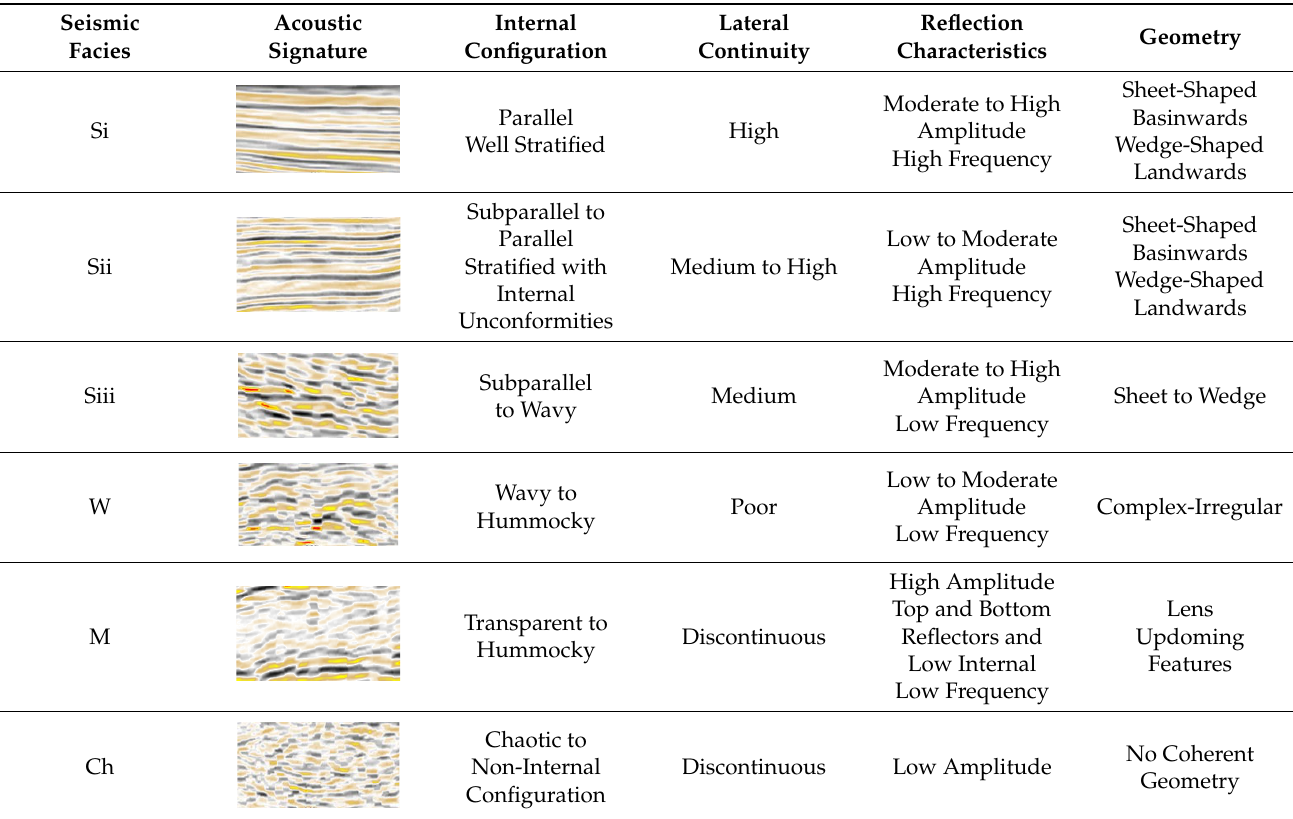
Table 1. Seismic facies recognized across the four domains and their definitive characteristics.